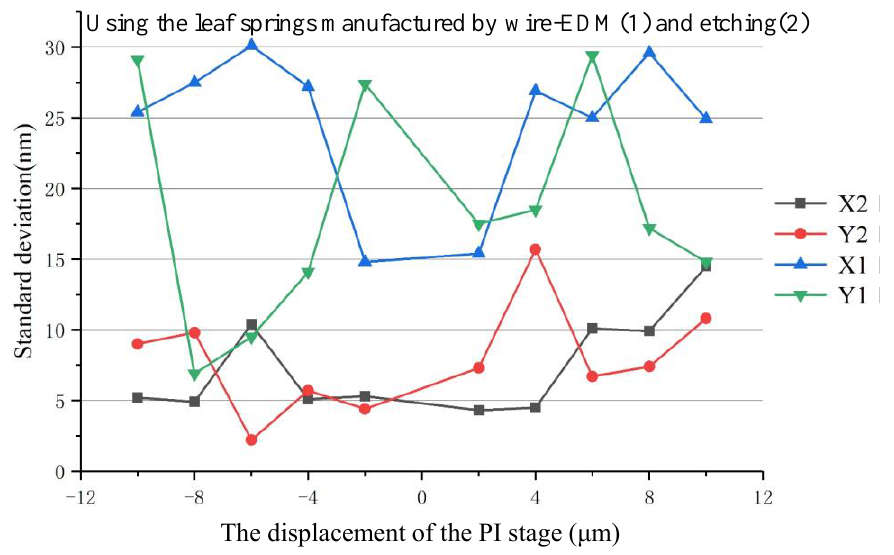
Figure 11. Results of the experiments.